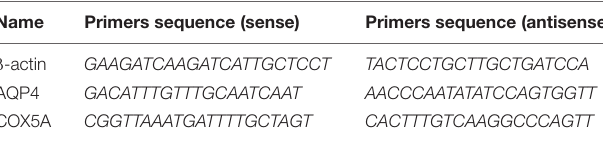
TABLE 3 | Detailed information on the selection of primers for RT-PCR